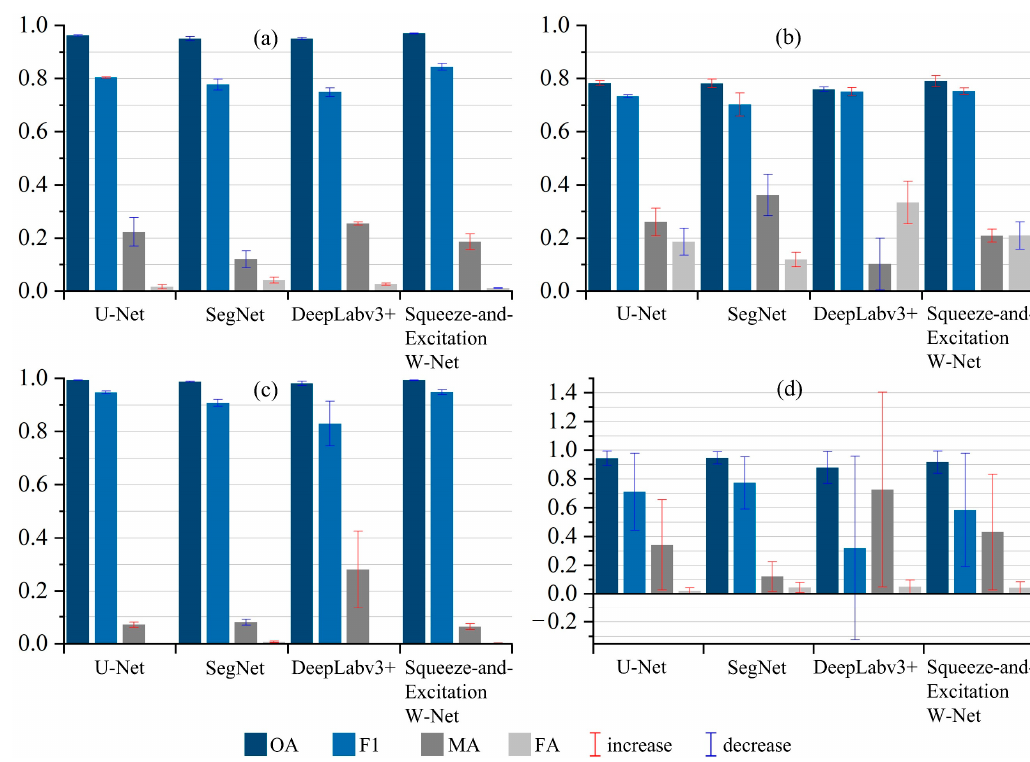
Figure 15. Binary change maps (Experiment 4) obtained by the ( a ) U-Net_Multi-feature, ( b ) SegNet_Multi-feature, ( c ) DeepLabv3+_Multi-feature, ( d ) squeeze-and-excitation W-Net_Multi-feature, ( e ) U-Net_only-image, ( f ) SegNet_only-im- age, ( g ) DeepLabv3+_only-image, and ( h ) squeeze-and-excitation W-Net_only-image.